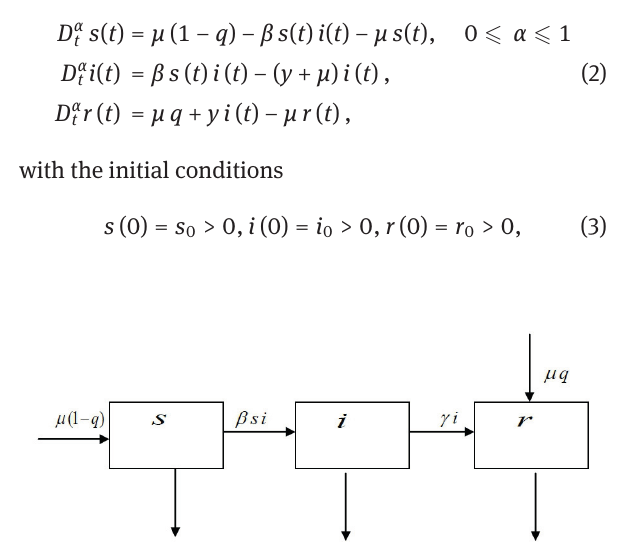
Fig. 1. Flow chart for the SIR model with constant